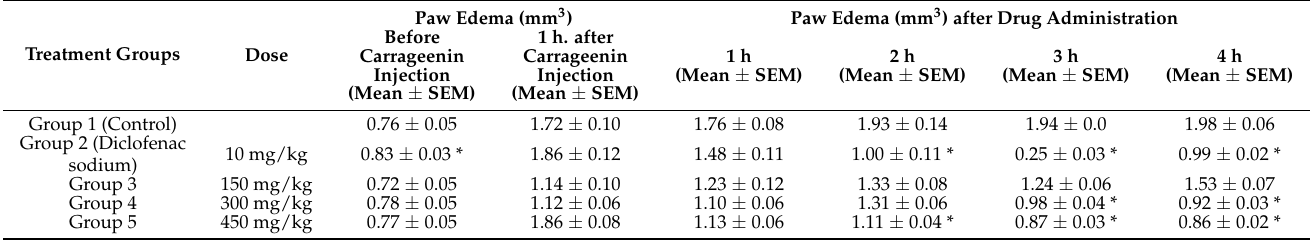
Table 2. Anti-inflammatory potential in methanolic extracts of different doses. All treatments consist of 5 groups. Each group has 3 replicates. Each group of mice was treated with a different methanolic extract/dose. The expression of value was mean ± SEM based. The mean difference was considered statistically significant at the 0.05 level. Significance indicated (* p < 0.05).